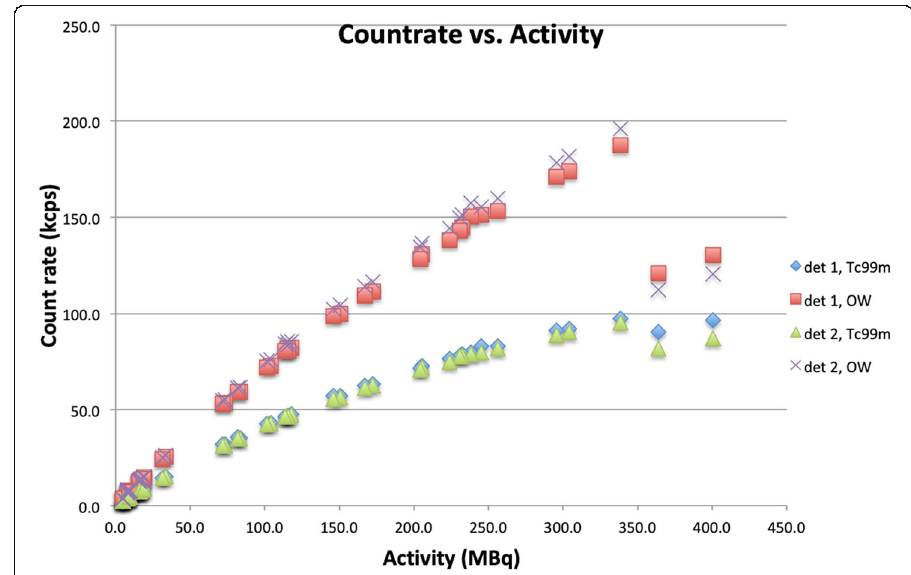
Fig. 1 The measured count rate (kcps) vs. activity (MBq) for the intrinsic measurement for both detectors, both OW and 99m Tc energy windows. Note the sharp, step-like, decrease in count rate (for both detectors and both energy windows) above approx. 350 MBq